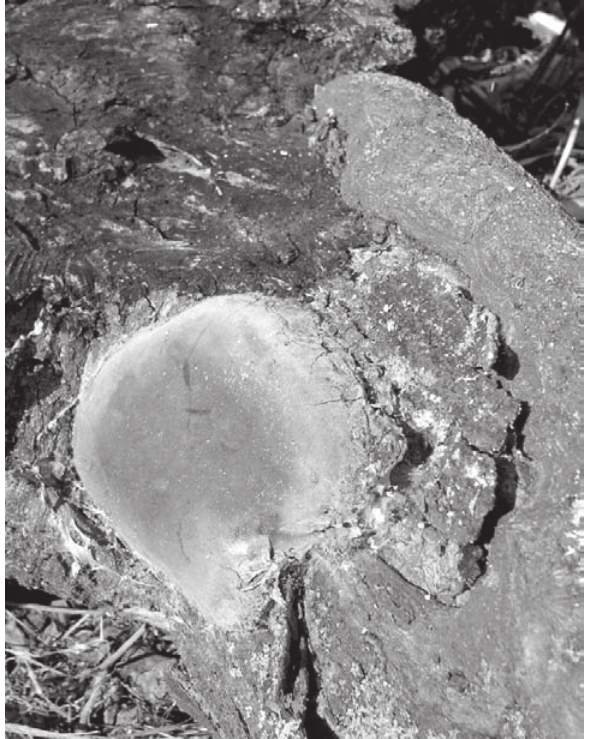
Fig. 2 . Fruit body of Fomitiporia mediterranea on the canker of an orange-tree